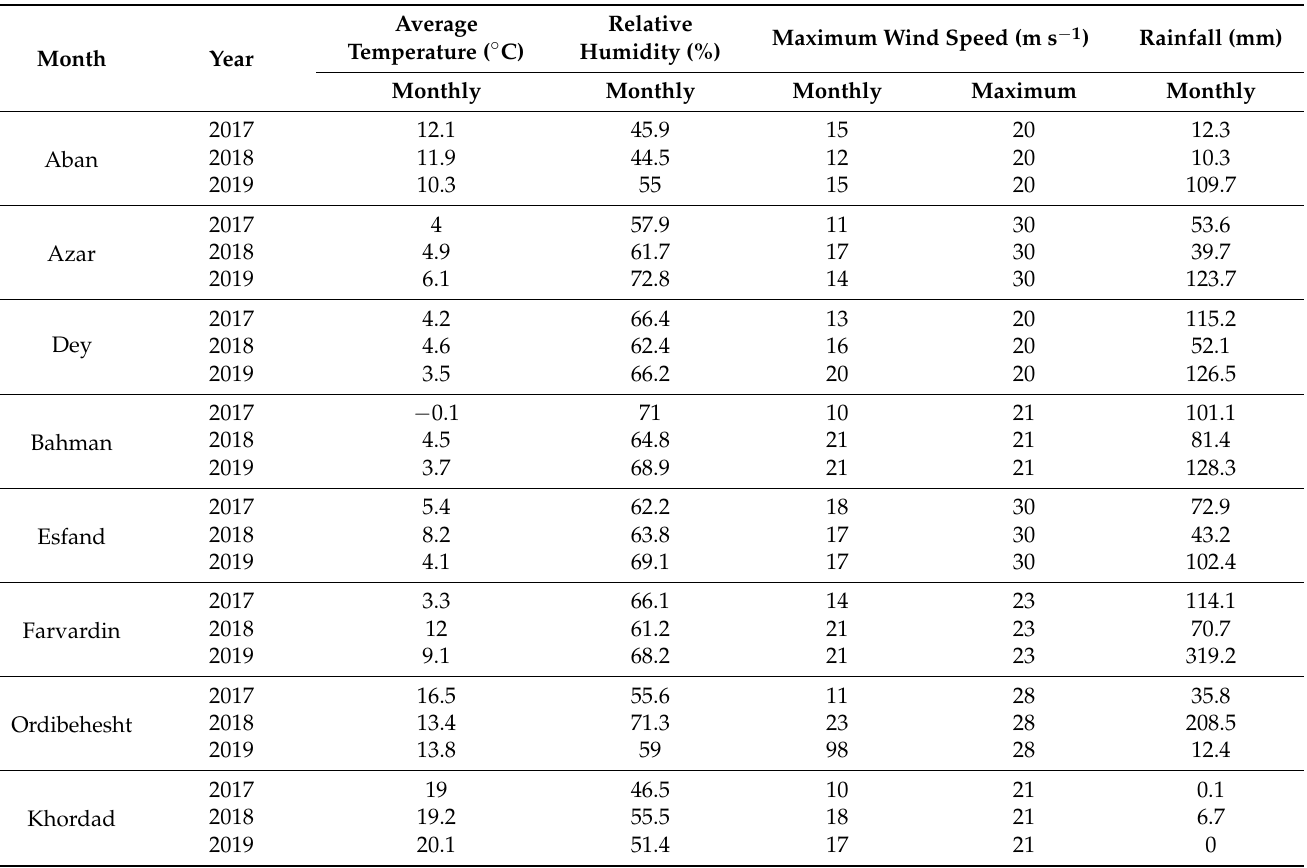
Table 5. Average monthly meteorological data of Aleshtar city meteorology